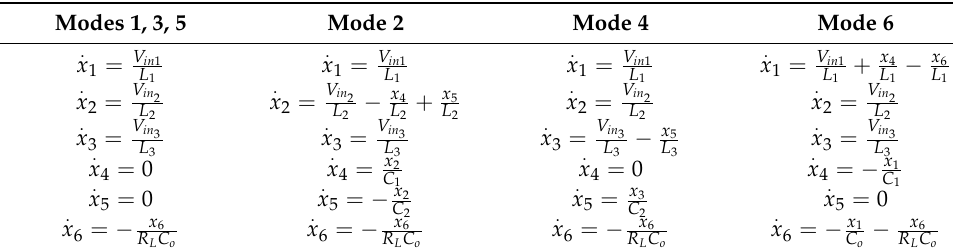
Table 1. State space